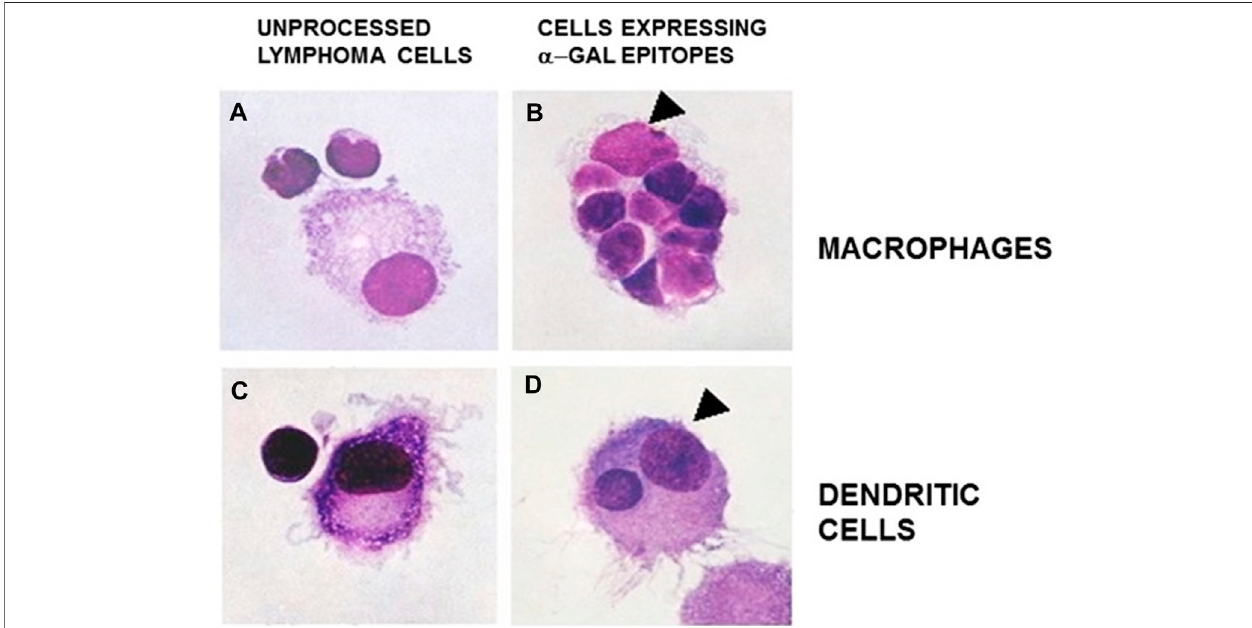
FIGURE 4 | Anti-Gal – mediated uptake of human B lymphoma cells by autologous APCs. Human fresh B lymphoma cells were glycoengineered to present α -gal epitopes as illustrated in Figure 2 . Lymphoma cells presenting α -gal epitopes (B and D) or lacking this epitope (A and C) were incubated with autologous anti-Gal for 30 min and, subsequently, for 2 h at 37 ° C with autologous macrophages (A and B) or dendritic cells (C and D) . The cells were washed and stained. Arrowheads mark nuclei of the APC. Note uptake of nine lymphoma cells presenting α -gal epitopes by the macrophage and one lymphoma cell by the dendritic cell. No uptake of lymphoma cells lacking α -gal epitopes was observed (May Grünwald Giemsa staining, × 1,000). Adapted with permission from Manches et al. (2005), with